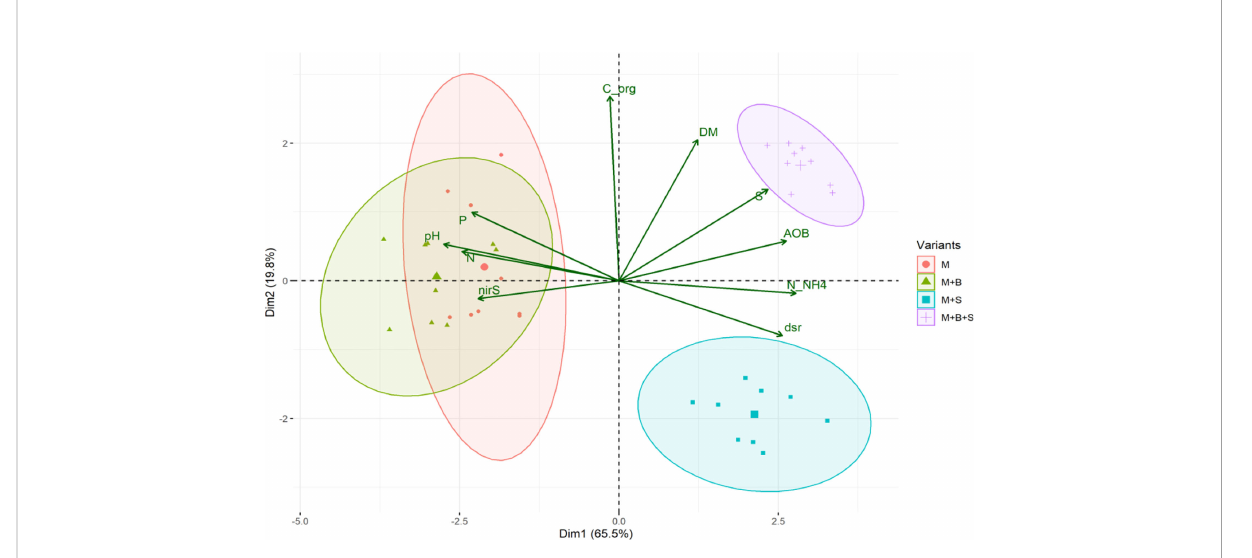
FIGURE 3 The PCA biplot of the maturated manure